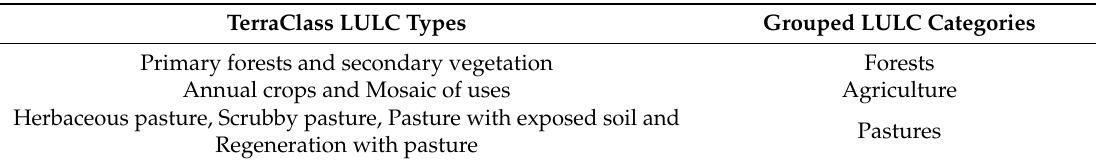
Table 1. Summary of TerraClass land use and land cover (LULC) types, which were grouped for developing this